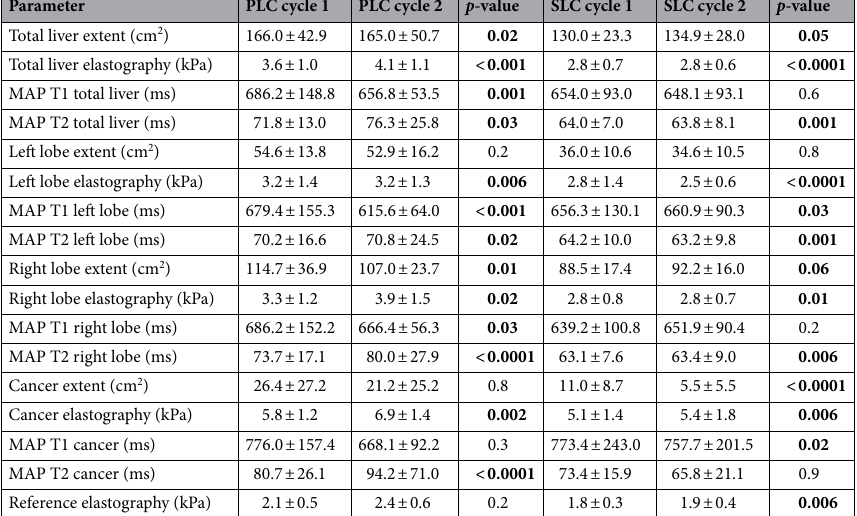
Table 2. Comparison of results after the first and the second TACE therapy in the group of PLC and SLC. kPa Kilo pascal. Significant values are in bold.